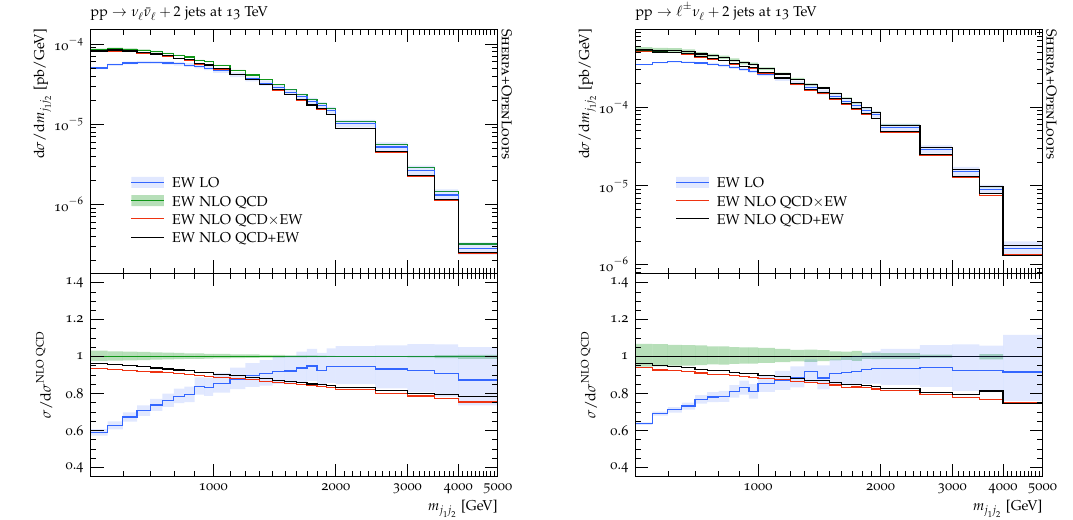
Figure 8. Distribution in the invariant mass of the two hardest jets, m j Z ( ν ‘ ¯ ν ‘ ) + 2 jets (left) and EW pp → W ± ( ‘ ± ν ‘ ) + 2 jets (right). Curves and bands as in figure 6.